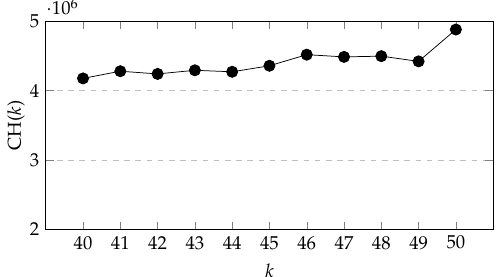
Figure 11. Varying k for CH( k ) ( k ∈ { 40, . . . ,50 }